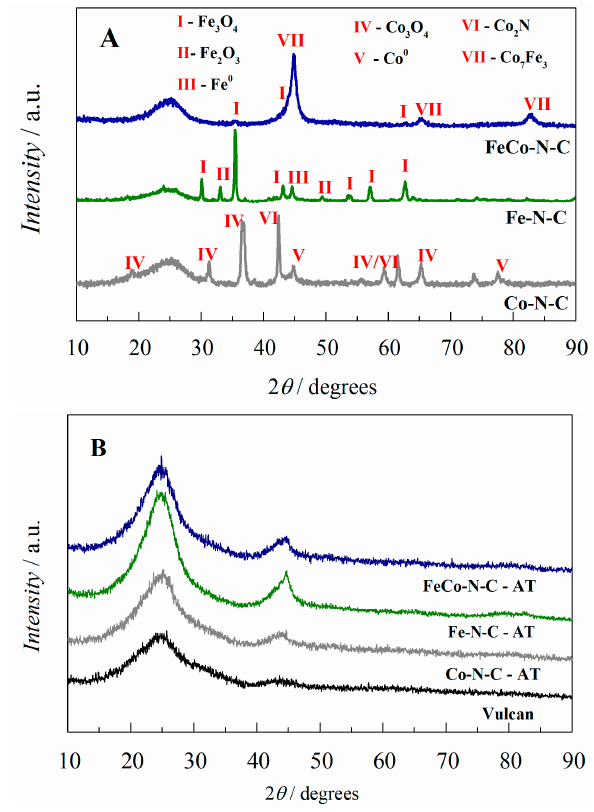
Figure 1. X-ray diffractograms obtained for ( A ) Fe-N-C, Co-N-C and FeCo-N-C, and ( B ) for the same electrocatalysts but after acid treatment. The result obtained for Vulcan carbon is shown for comparison.